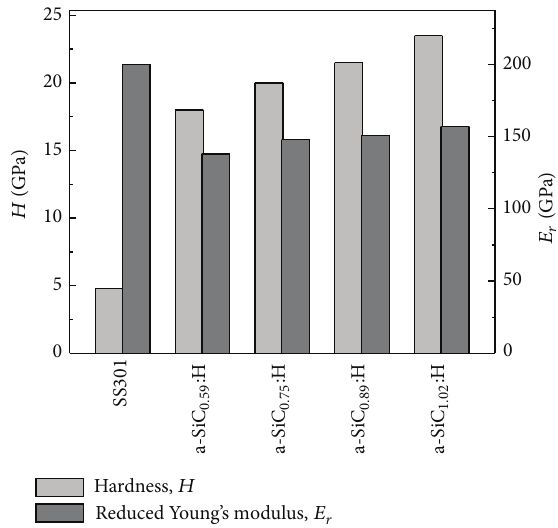
Figure 4: Mechanical properties of a-SiC